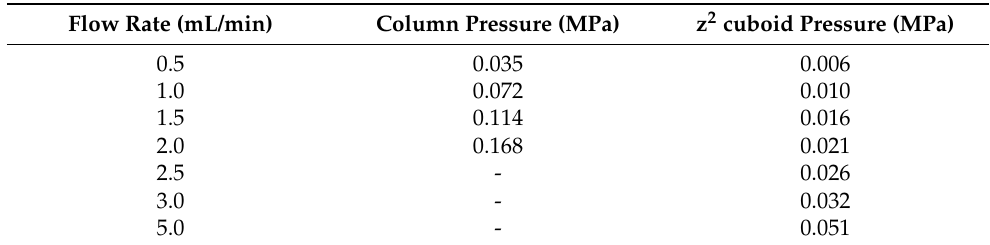
Table 1. Pressure drop at different flow rates for Sephacryl S-200 HR medium packed 24 mL Tricorn GL 10/300 column and 24 mL z 2 cuboid SEC device (mobile phase: phosphate-buffered saline, pH 7.4). Flow Rate (mL/min) Column Pressure